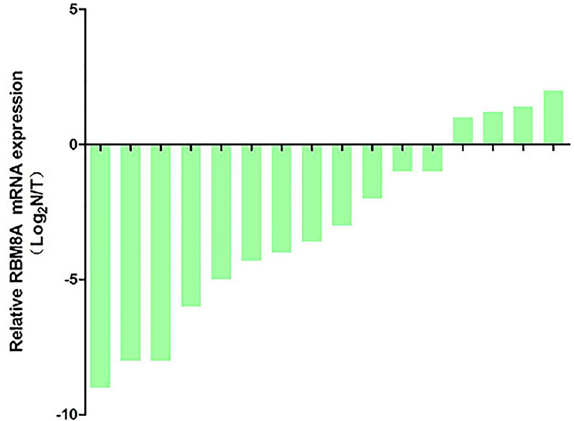
Figure 1. mRNA expression of RBM8A in 16 paired gastric carcinoma samples and adjacent tissues. Data are reported as the ratio of adjacent tissues (N)/carcinoma samples (T).